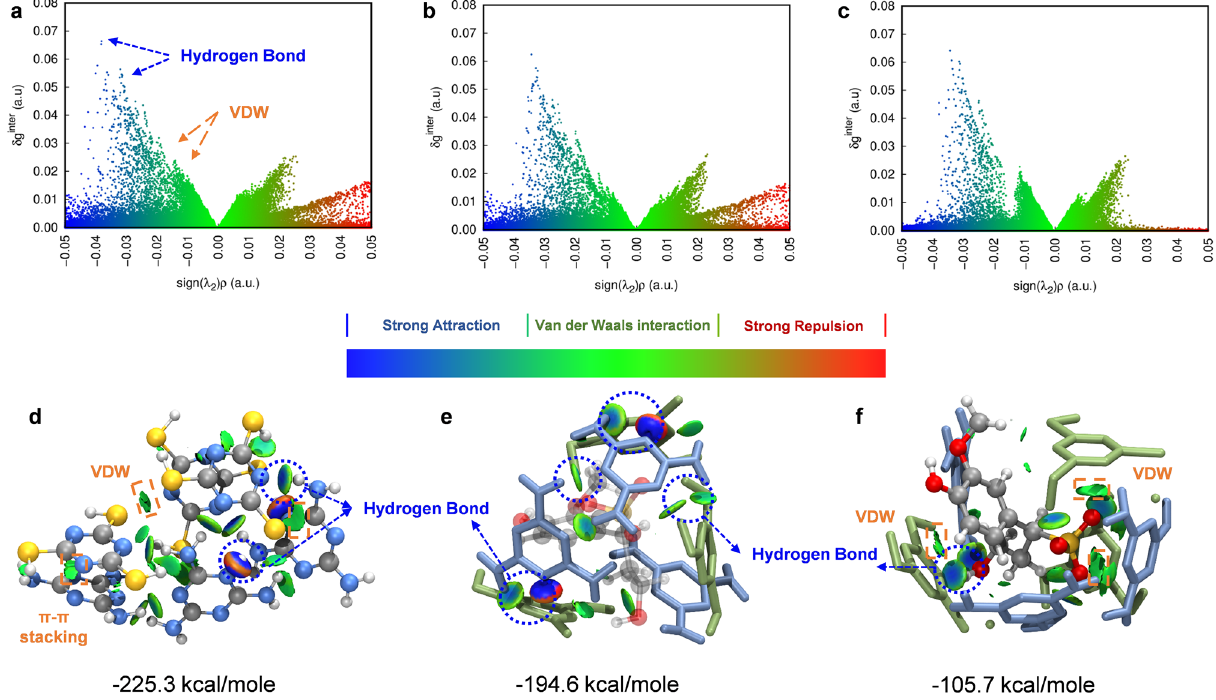
Fig. 1 a‑c Scatter graph and d‑f isosurface (value = 0.01 electrons/Bohr. 3 ) of independent gradient model based on Hirshfeld partition (IGMH) for unveiling the interaction between MA and TCA with/without the interference of LS model molecule, respectively (MA + TCA assembly in ( d ) CPK model, C-gray, N-blue, H-white, S-yellow; MA + TCA + LS assembly in ( e, f ) licorice model, MA-blue,